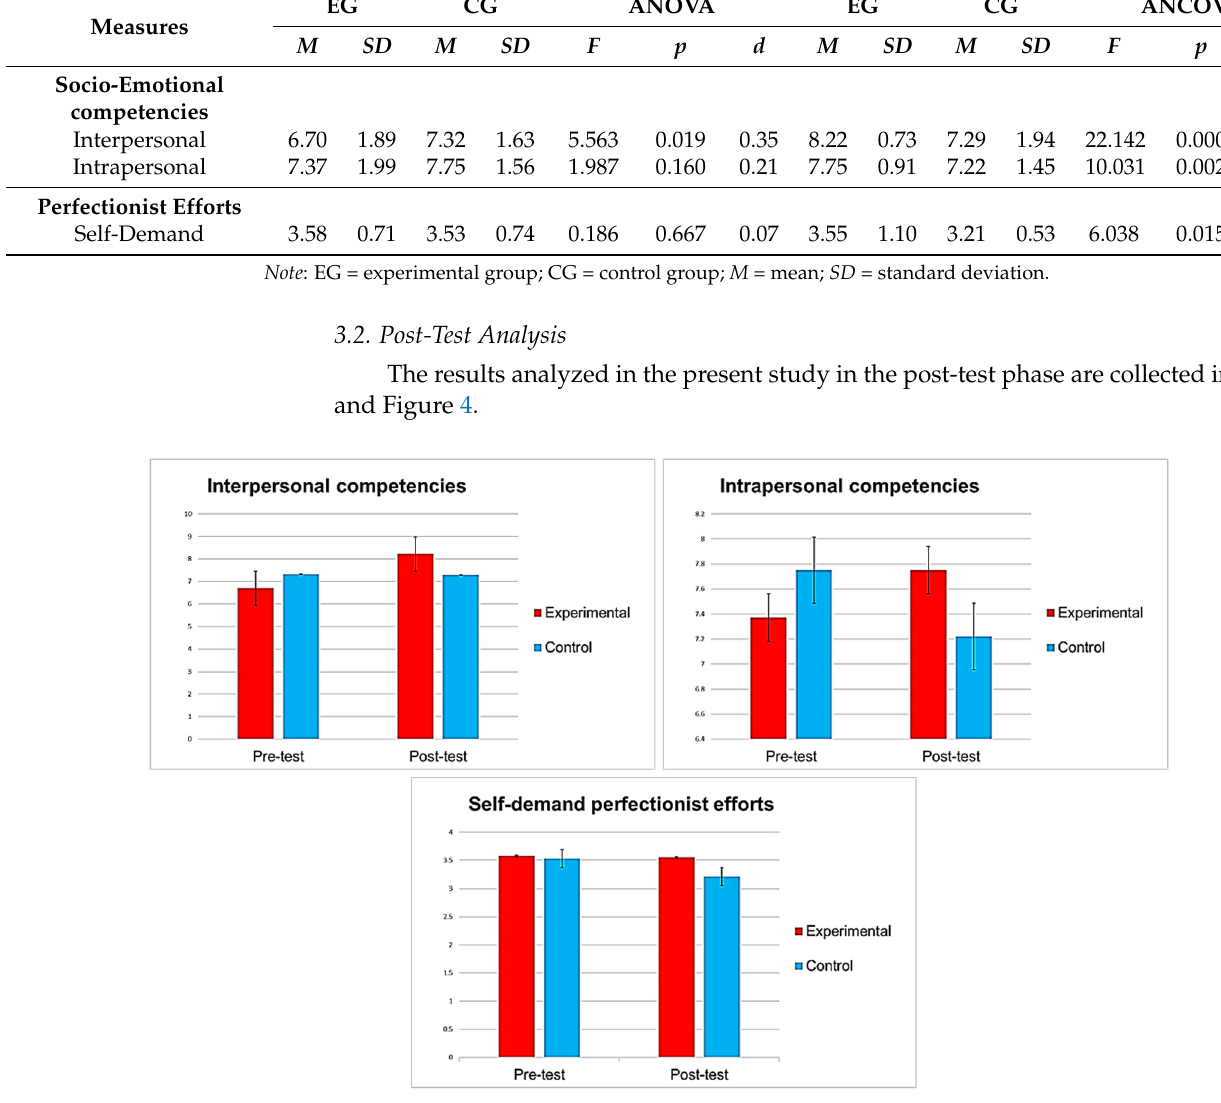
Figure 4. Significant effects of the MooN Program (SEM-based) in the experimental group.